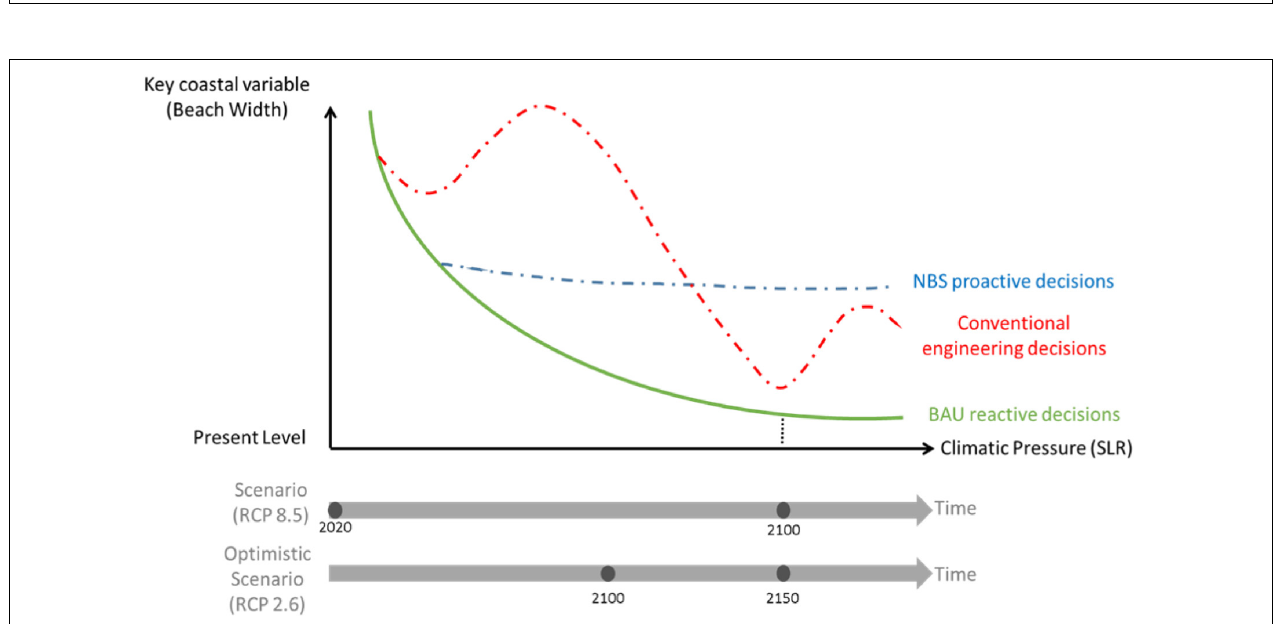
FIGURE 2 | Schematization of coastal trajectories against time and sea level rise (SLR), defined by some key variable (beach width in this case) and illustrating the effect of proactive versus reactive decisions. Beach width is a key variable to assess the three main functions of a beach: Protection, where the capacity to dissipate incoming wave energy depends critically on width; Economic support, where the emerged beach area is proportional to tourism and directly related socio-economic activities; and Ecological support, also depending on the width/height of the beach. The various types of possible interventions considered for the trajectories are: Business as usual, BAU reactive decisions (green line); Conventional engineering decisions, in a mixed reactive/proactive approach (red line); Nature Based Solutions, NBS, proactive decisions (blue line).